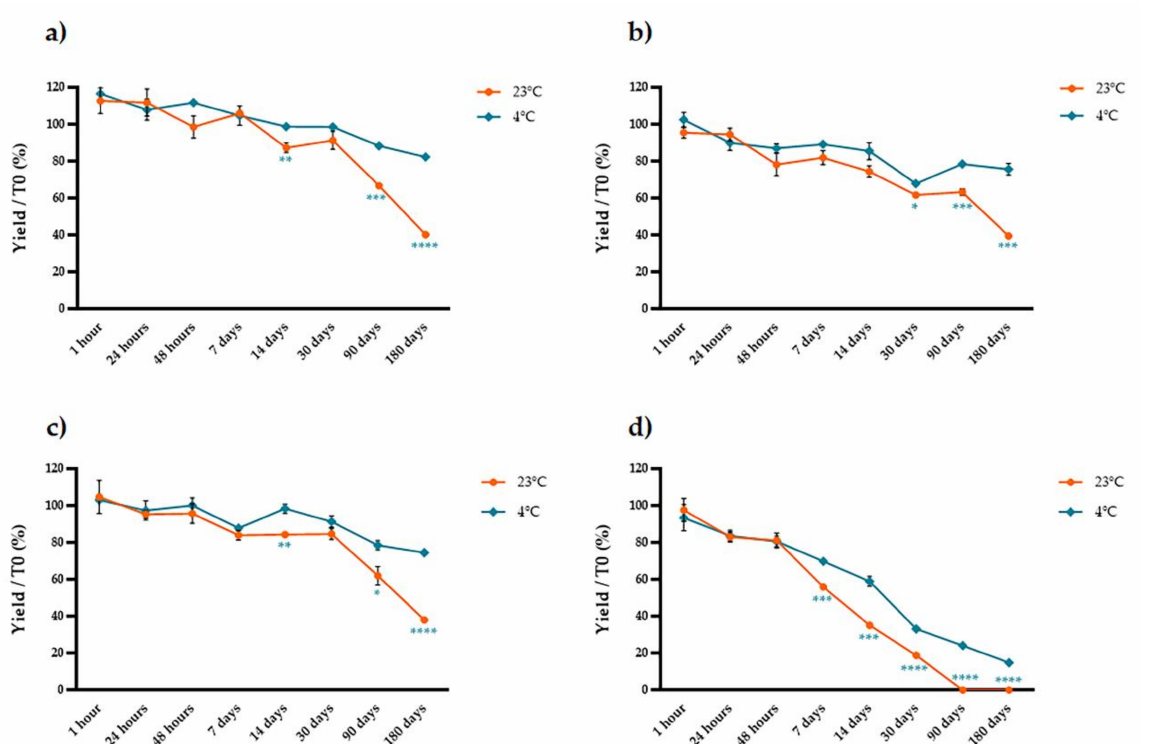
Figure 6. Stability over time of pure extracts prepared with different solvents and stored at 23 ◦ C (blue line) or 4 ◦ C (red line). The samples were extracted with ( a ) water, ( b ) 12.5% ethanol, ( c ) 25% ethanol, and ( d ) 50% ethanol. The y axis shows the yield as a percentage relative to the samples that were analyzed immediately after extraction. Significant differences between the two storage temperatures are indicated with asterisks (* p < 0.05, ** p < 0.01, *** p < 0.001, **** p < 0.0001). Data are means ± SD ( n = 3 independent experiments; multiple t -tests with Holm–Šid á k correction, p <